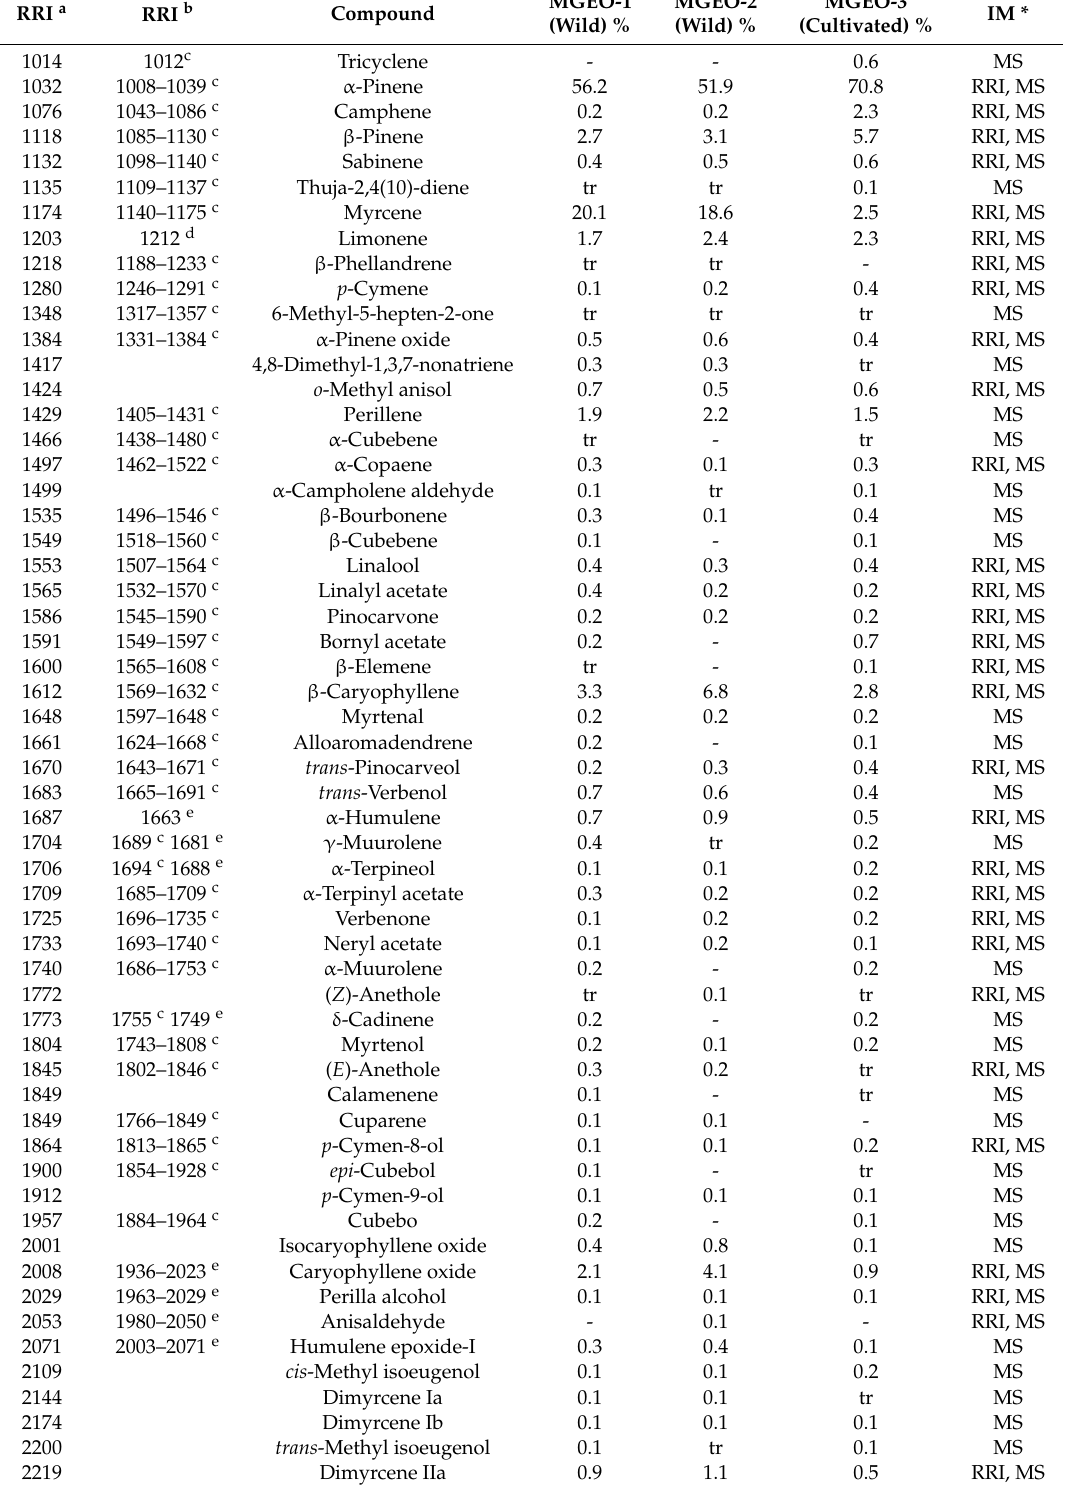
Table 1. Chemical composition of mastic gum essential oils (MGEOs) obtained from wild and cultivated mastic trees ( Pistacia lentiscus var. chia